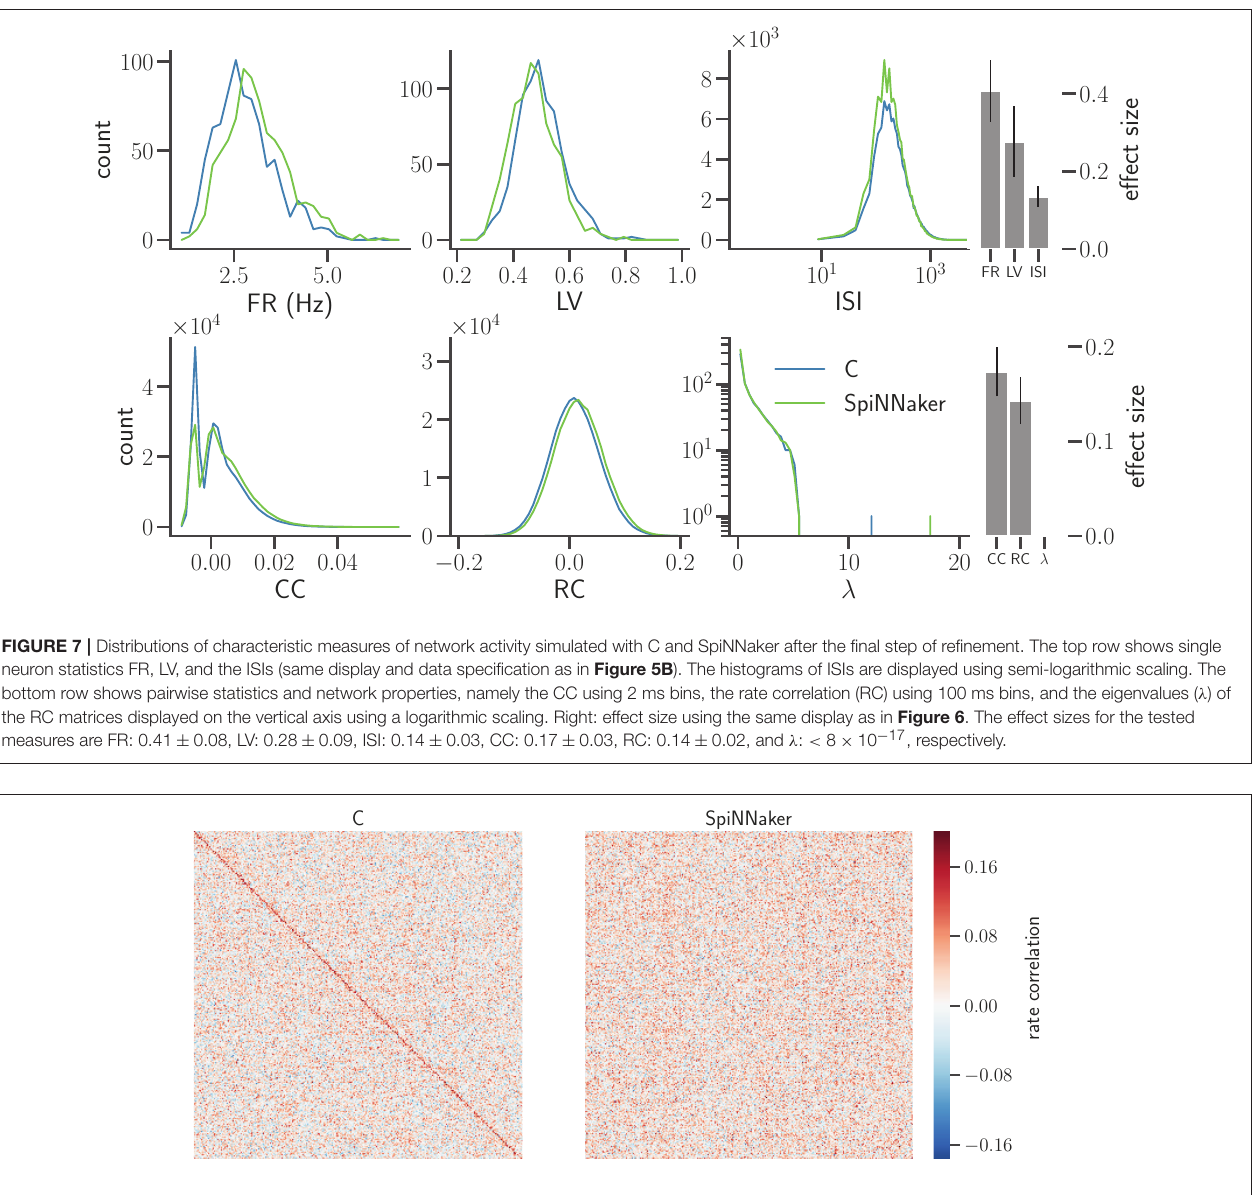
FIGURE 8 | Rate-correlation matrices for the C and SpiNNaker simulations of the network state after 5 h. Matrix elements show the RCs (color bar) of all pairs the 800 excitatory model neurons in the simulation computed from 60 s of data. The order of the neuron ids in both symmetric matrices is determined by hierarchical clustering (Ward’s variance minimization algorithm, details see Section 3.1.3) of the C matrix. Auto-correlations are set to 0 to not stretch the color scale.